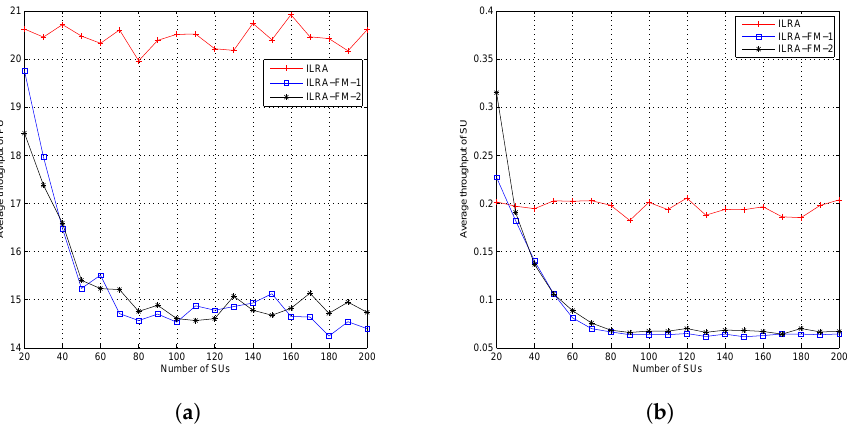
Figure 6. Throughput of the proposed algorithm at d c = 6 and d v = 8; ( a ) PU and ( b )